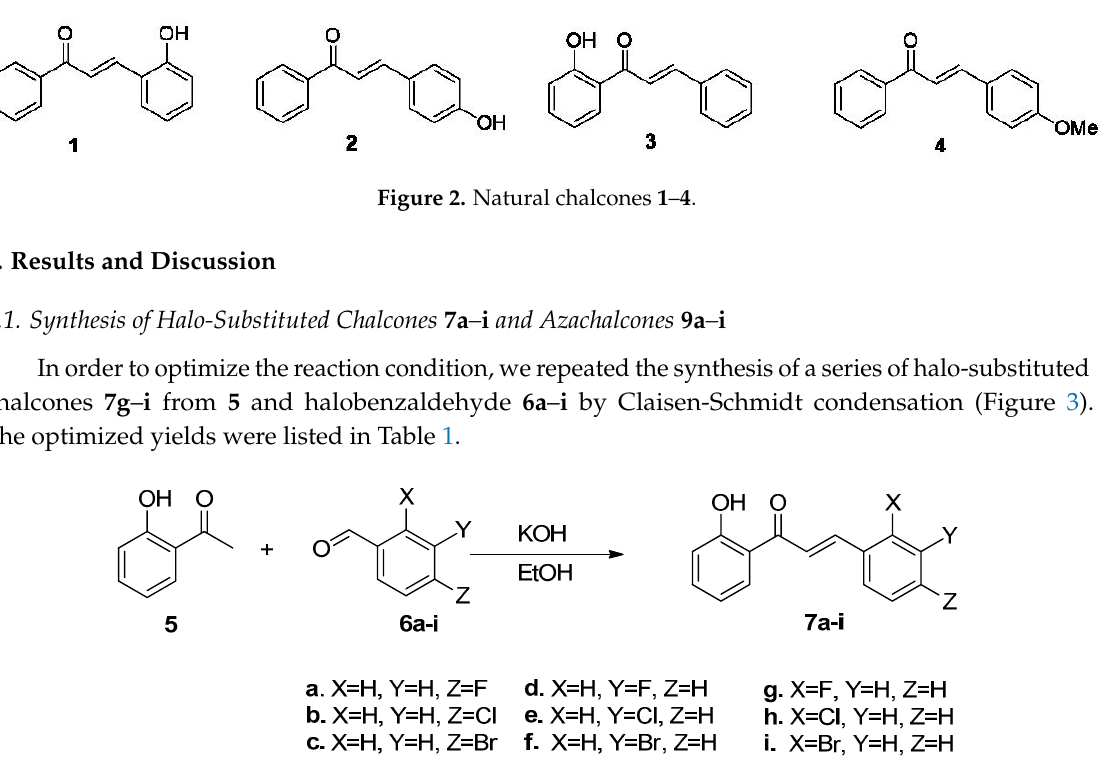
Figure 3. Claisen-Schmidt condensation in synthesis of chalcones 7a – i .